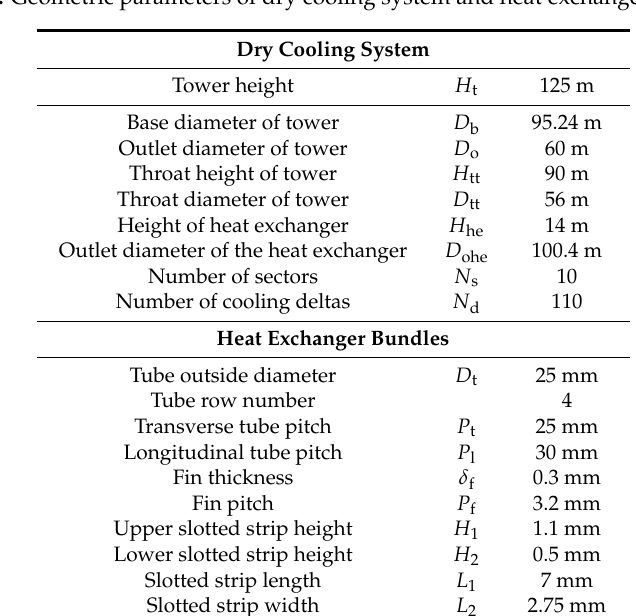
Table 1. Geometric parameters of dry cooling system and heat exchanger